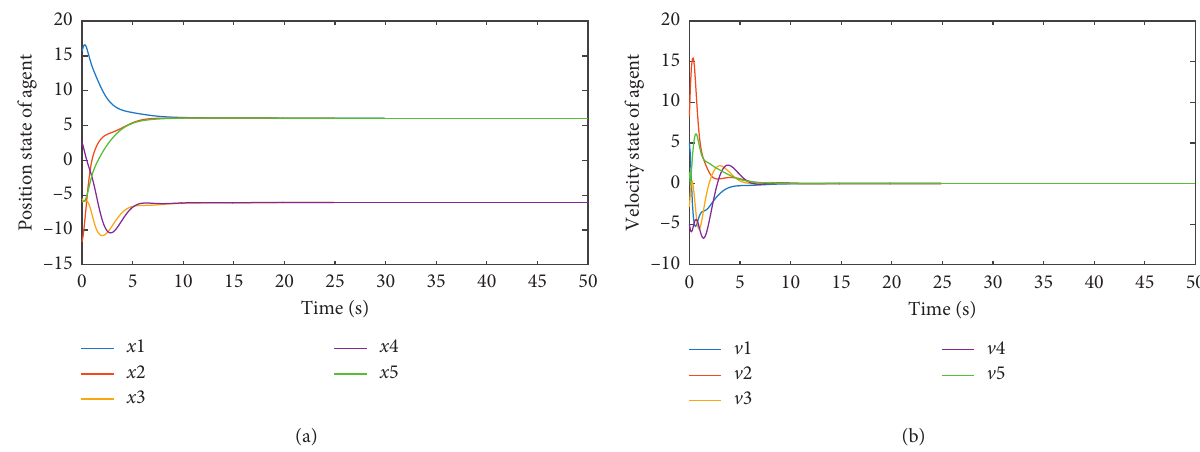
Figure 2: Position and velocity states of agents on the structurally balanced network in Figure